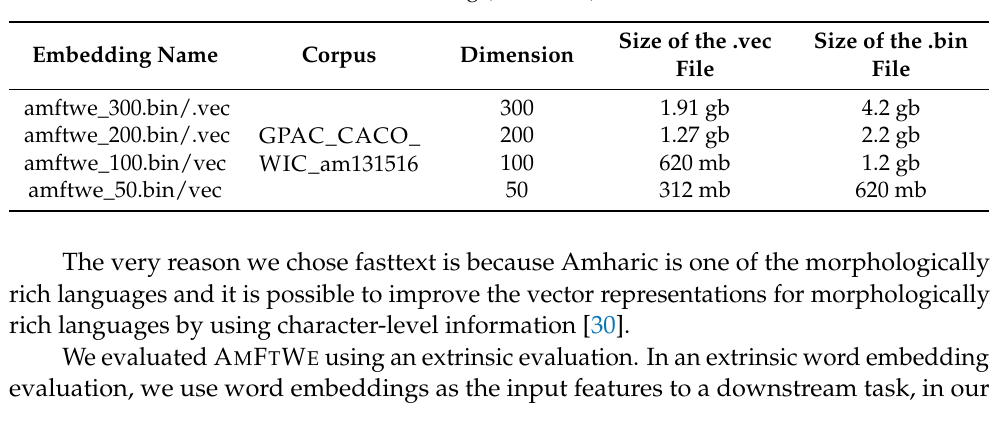
Table 3. The Amharic fasttext word embedding (A M F T W E )